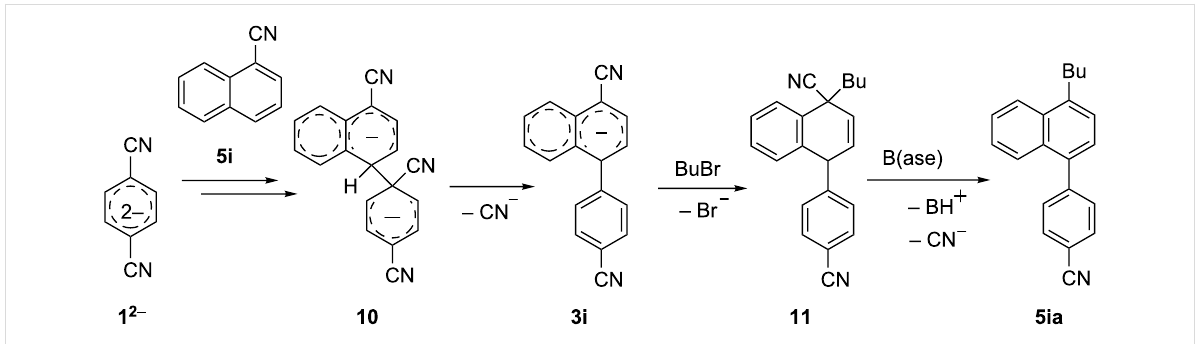
Scheme 3: para -Cyanophenylation of 1-cyanonaphthalene 5i by dianion 1 2 − with subsequent butylation providing 4-(4-butylnaphthalen-1-yl)benzo- nitrile ( 5ia